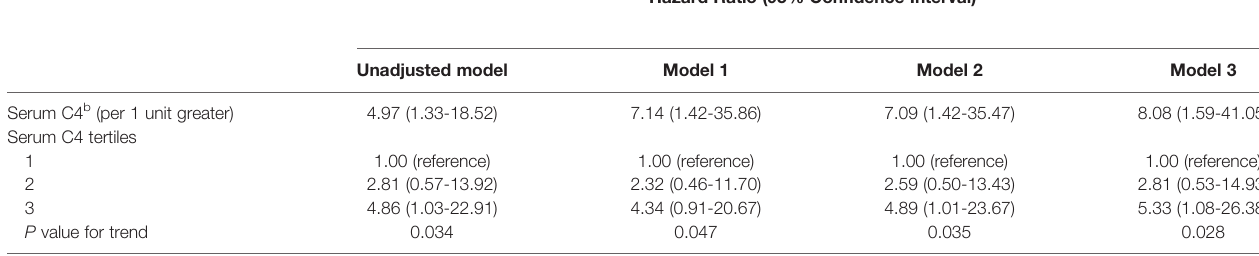
TABLE 6 | Cox proportional hazards ratio model of a renal function progression event a